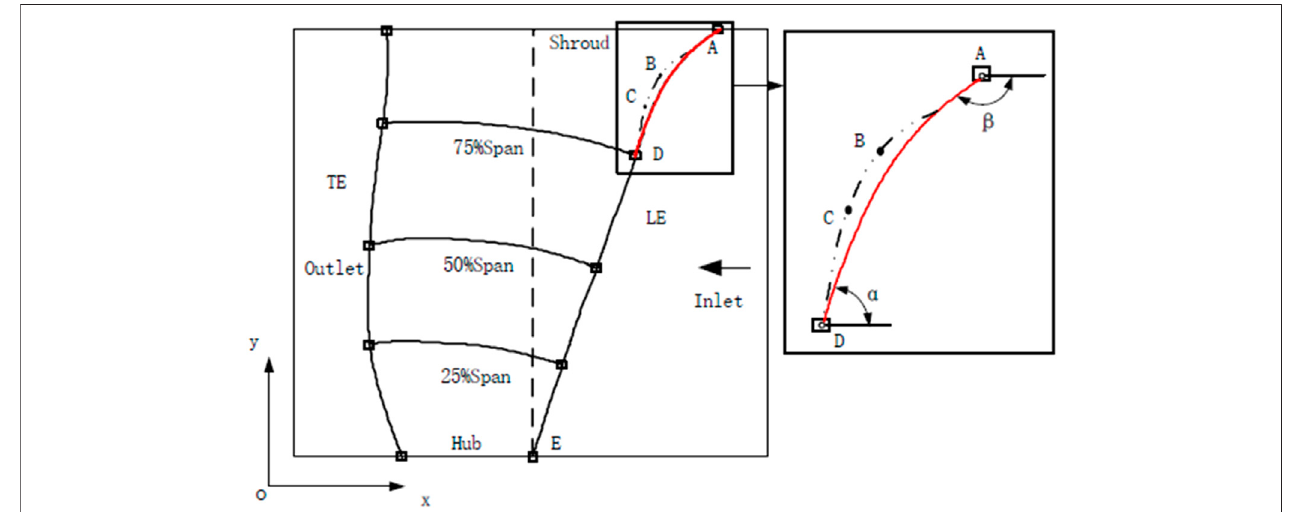
FIGURE 2 | Parameterization of an axial fan blade pro fi le.